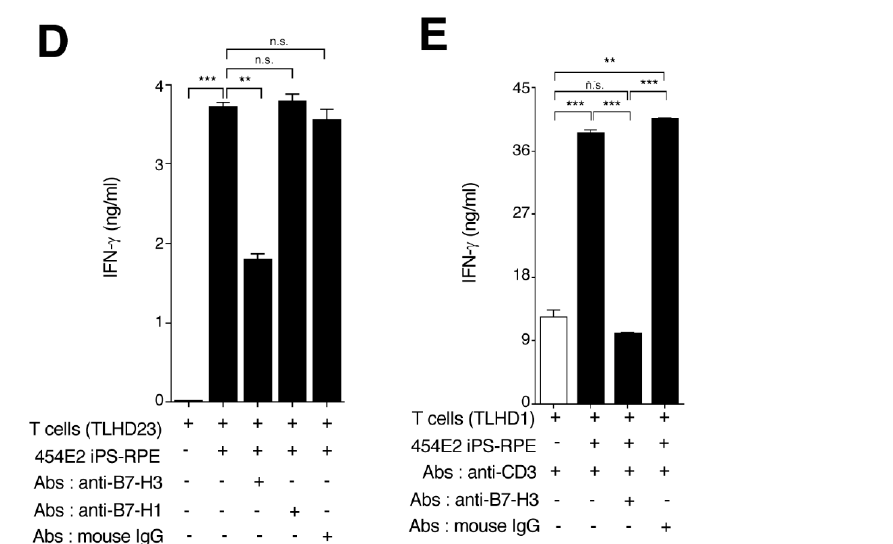
Figure 7. Capacity of human iPS-RPE cells to stimulate the activation of bystander T cells via B7-H3. Recombinant human B7-H3 proteins were used in in vitro assays with lymphocytes. ( A ) PBMC were cocultured with recombinant B7-H3 (0.5. 5, 50, or 200 ng/mL) in the presence of antihuman CD3 antibody for 72 h. The supernatants were harvested for IFN- γ ELISA. ( B ) Purified CD4 + T cells were cocultured with recombinant B7-H3 (5 or 50 ng/mL) and evaluated by IFN- γ ELISA. ( C ) Purified CD8 + T cells were cocultured with recombinant B7-H3 (5 or 50 ng/mL) and evaluated by granzyme B ELISA. Data are the means ± SEM of 3 ELISA determinations. * p < 0.05, ** p < 0.005, as compared to positive controls (open bar: no recombinant B7-H3). Data are representative of 3 individual experiments. ( D ) CD4 + T cells were cocultured with iPS-RPE cells (454E2) in the presence of antibodies such as anti-B7-H3, anti-B7-H1, or isotype control (mouse IgG) and assessed by IFN- γ ELISA (T cell:RPE ratio = 100:1). ( E ) CD4 + T cells were also cocultured with iPS-RPE cells in the presence of anti-CD3 (1 st signal blocking) plus anti-B7-H3 (2 nd signal blocking) and assessed by IFN- γ ELISA (T cell:RPE ratio = 100:1). Data are the means ± SEM of 3 ELISA determinations. ** p < 0.005, *** p < 0.0005, as compared to 2 groups. n.s., not significant.